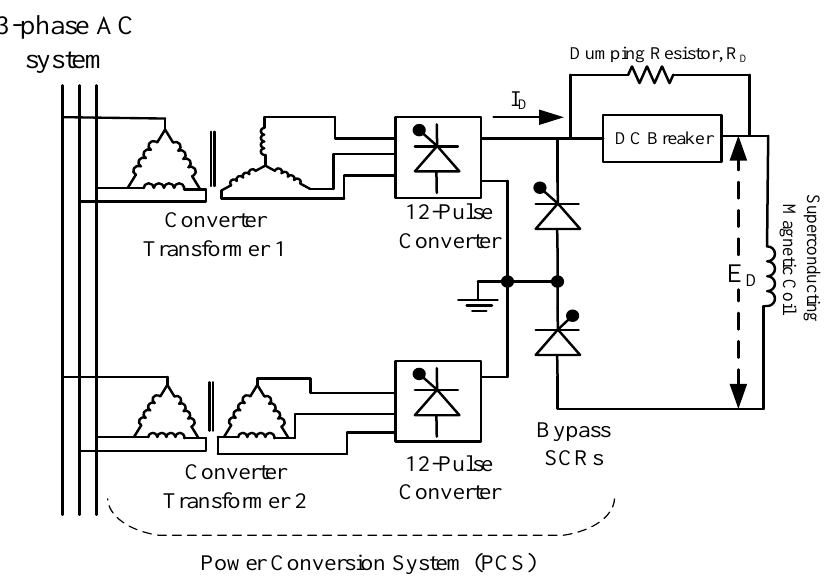
Figure 3. SMES basic configuration.